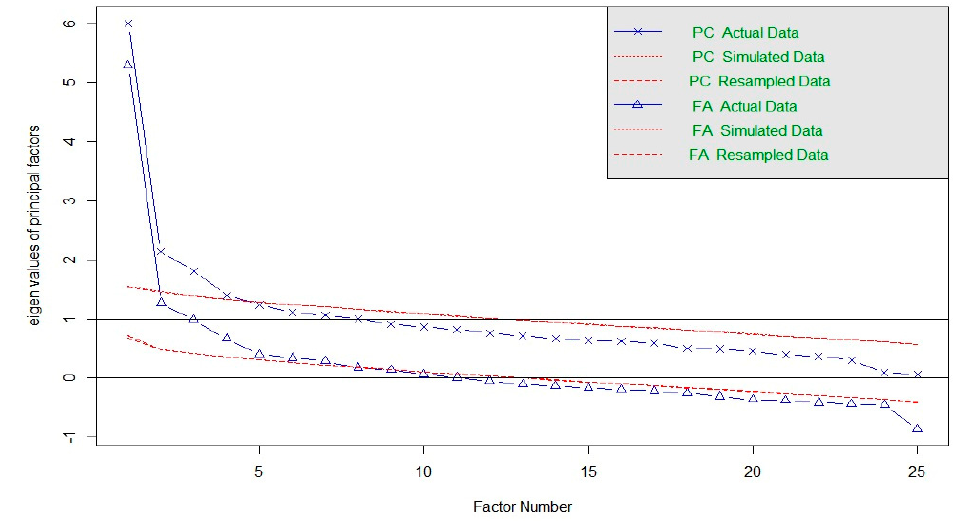
Figure 1. Scree plot of Horn’s parallel analysis.